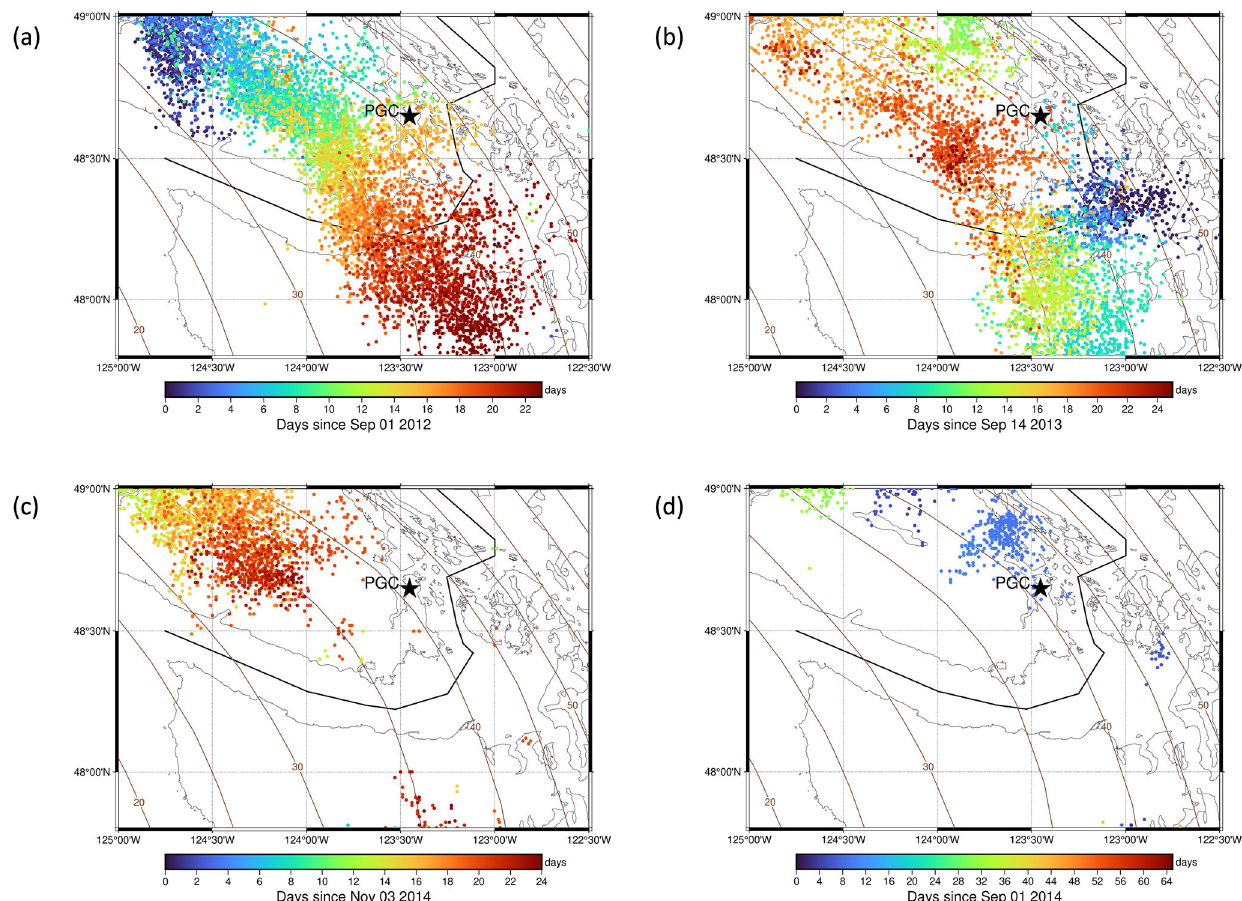
Fig. 7 Temporal and spatial distribution of ETS events. Location and timing of tremor during ( a ) 2012 main ETS event, ( b ) 2013 main ETS event, ( c ) 2014 main ETS event, and ( d ) the 2014 minor ETS event. Contours show Cascadia plate interface geometry based on the slab contours of McCrory et al. 72 . The maps were created by using the Generic Mapping Tools (GMT) 71